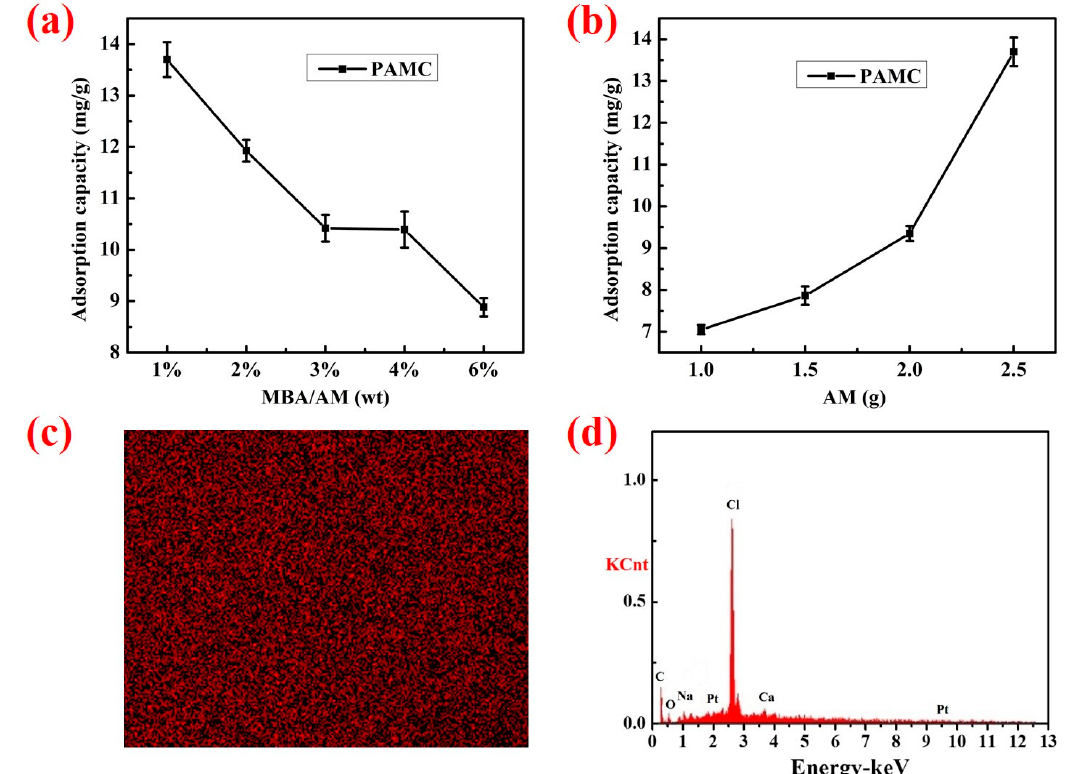
Figure 8. Effect of AM ( a ) and MBA ( b ) content on adsorption capacity of PAMC in the sea sand environment; the chloride content ( c ) and elemental distribution ( d ) in PAMC gels after being ad- sorbed in sea sand.